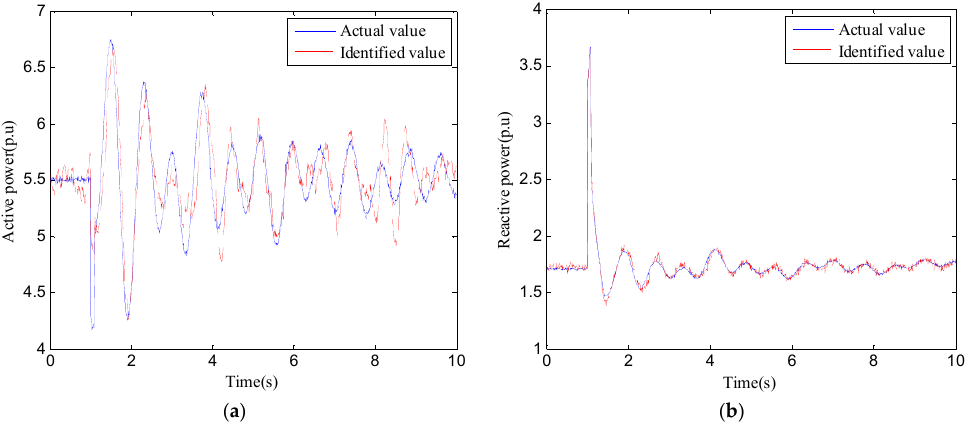
Figure 7. ( a ) Active power curves based on identified parameters and actual parameters; ( b ) reactive power curves based on identified parameters and actual parameters. Table 2. Comparison of the identified parameters and the actual parameters of the model for 50 dB signal ‐ to ‐ noise ratio (SNR) inputs (p.u).